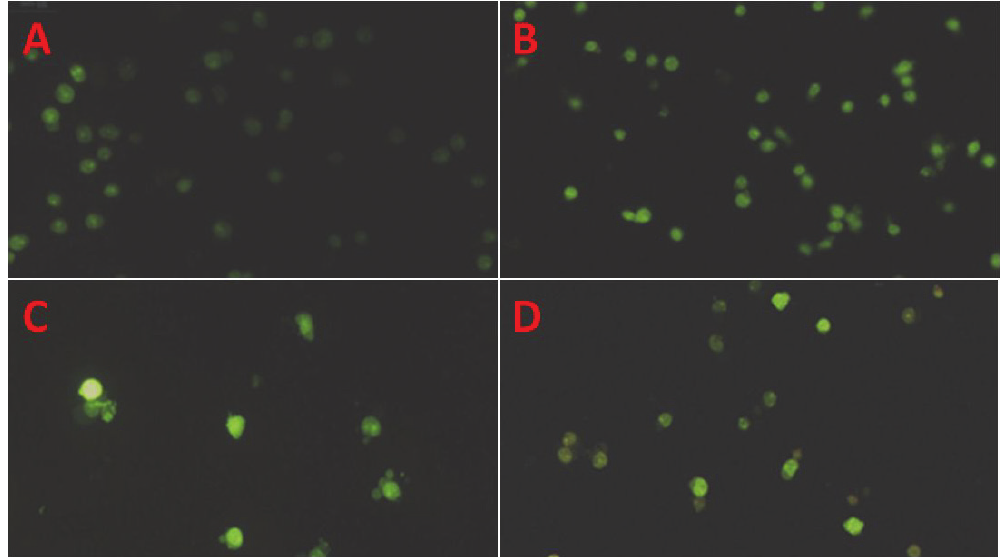
Figure 9: Annexin V/PI and ethidium bromide/acridine orange (AO/EB) staining in cell lines of Molt-4 treated with ZnO NPs: (a) control, (b) 4 ppm ZnO NPs, (c) 5 ppm ZnO NPs, (d) 6 ppm ZnO bright green dots in their nuclei representing nuclear fragmentation) and apoptoticlate (blebbing of plasma membrane) in the cell lines.